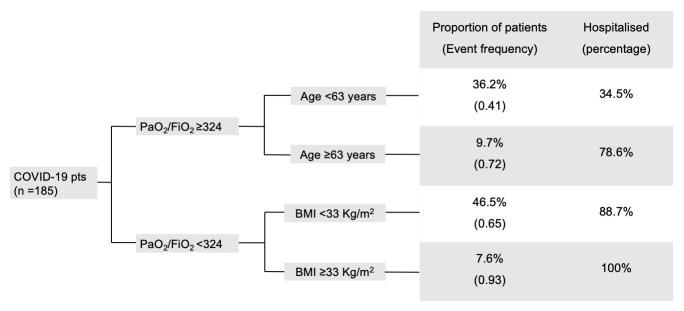
Regression tree analysis (RT 1) to predict the need of post-discharge follow-up among patients recovered from COVID-19.Event frequency defines the proportion of patients needing follow-up. The prevalence of hospitalisation in the obtained groups is depicted. Age, gender, ethnicity, history of hypertension, coronary artery disease, chronic kidney disease, diabetes mellitus, body mass index (BMI), axillary body temperature, ratio of arterial oxygen partial pressure to fractional inspired oxygen (PaO2/FiO2), aspartate transaminase, lactic dehydrogenase, and C-reactive protein at Emergency department presentation, and hospitalisation were included in RT 1 analysis. PaO2/FiO2 was available for 155 patients. BMI was available for 160 patients. Pts, patients. PaO2/FiO2, ratio of arterial oxygen partial pressure to fractional inspired oxygen. BMI, body mass index.